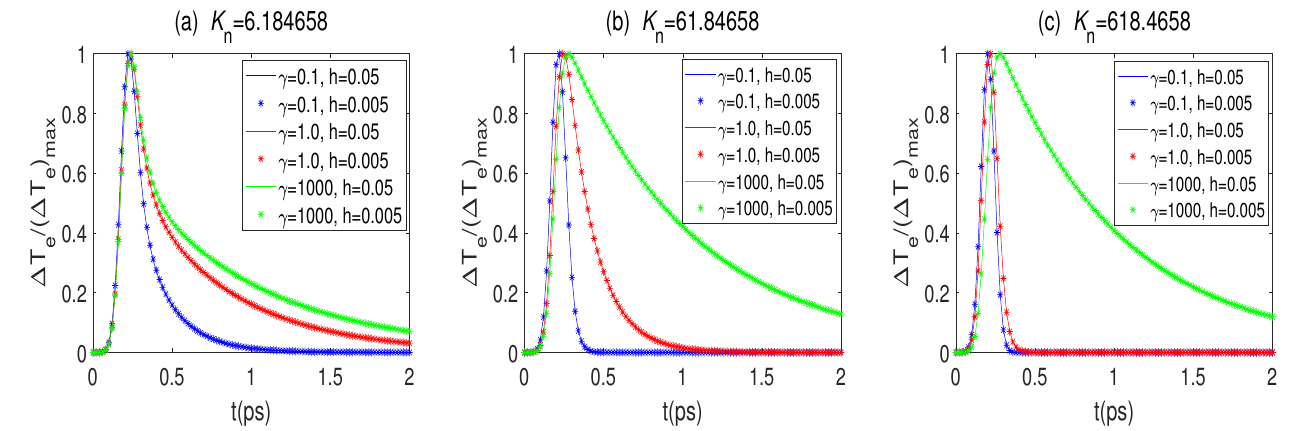
Figure 1. Changes in electron temperature ∆ T e / ( ∆ T e ) max and various K n , γ , and ( α , β ) = ( 0.999,0.999 )